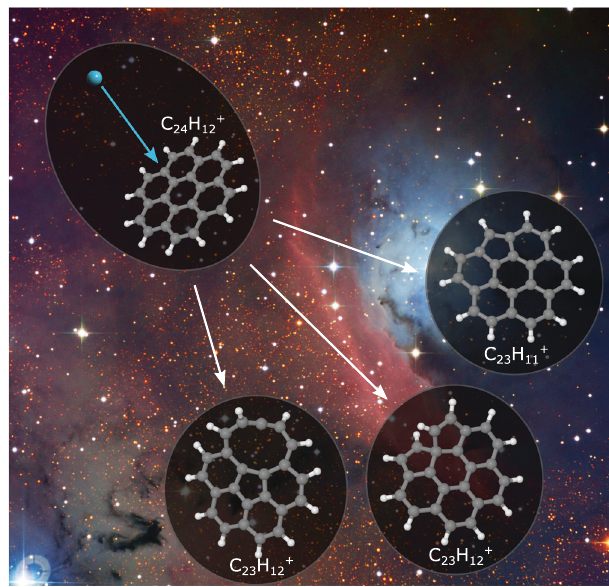
Fig. 1 Examples of reaction pathways when a PAH molecule (here a coronene cation) is damaged by the knockout of a C atom in a collision with an energetic particle. These types of reactions are proposed to take place in the ISM where PAH molecules/ions are abundant. The calculated C 23 H þ x structures are from Stockett et al. 26 . Background image credit: